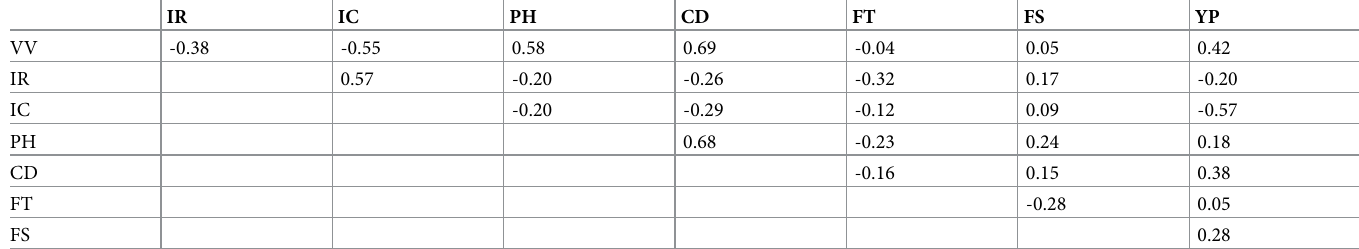
Table 3. Genotypic correlation among the following traits: Vegetative vigor (VV), incidence of rust (IR), incidence of cercosporiosis (IC), plant height (PH), canopy diameter (CD), fruit ripening time (FT), fruit size (FS), and yield per plant (YP), evaluated in the conilon coffee